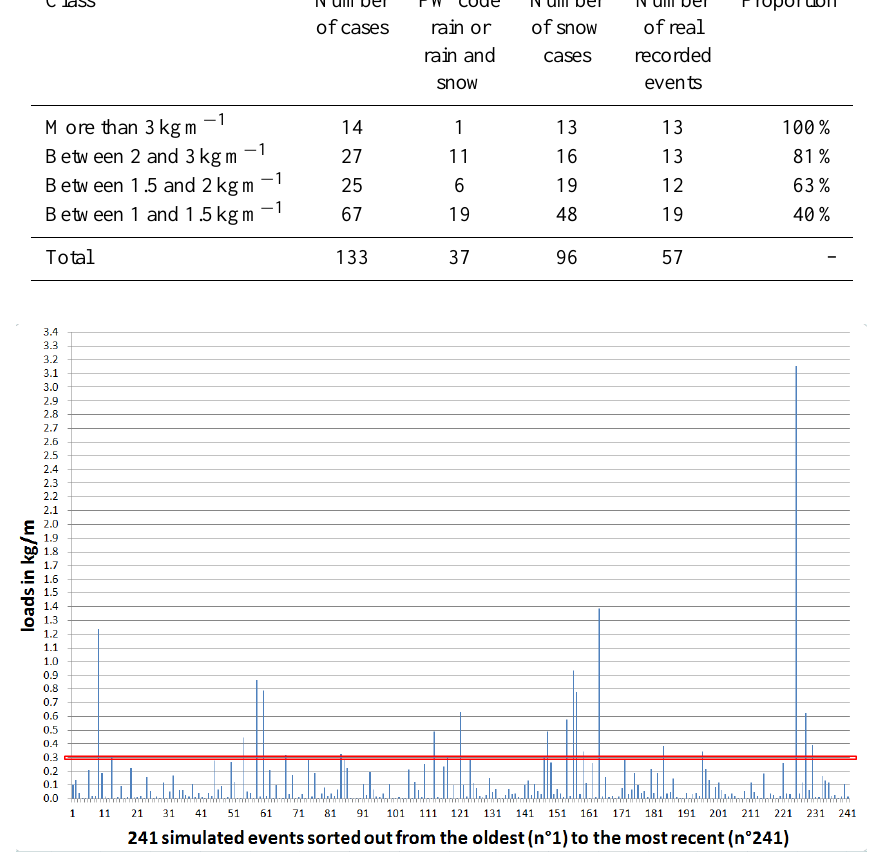
Figure 3. Calculated loads for the Lille weather station with 0.3kg m − 1 threshold (red line).